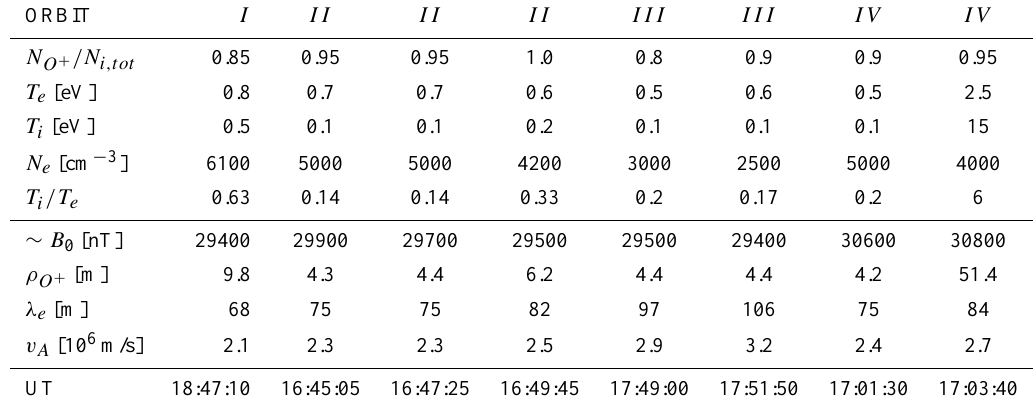
Table 2. Values from the probe sweeps. Data in the top five rows originate from the evaluation of the probe sweeps. The values in the middle four rows are calculated using the assumption of a 100% oxygen plasma. The last row shows the time of the probe sweeps.